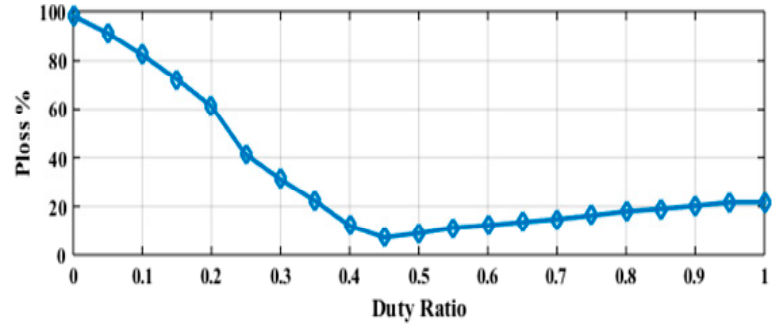
Figure 7. PA power loss versus duty ratio.